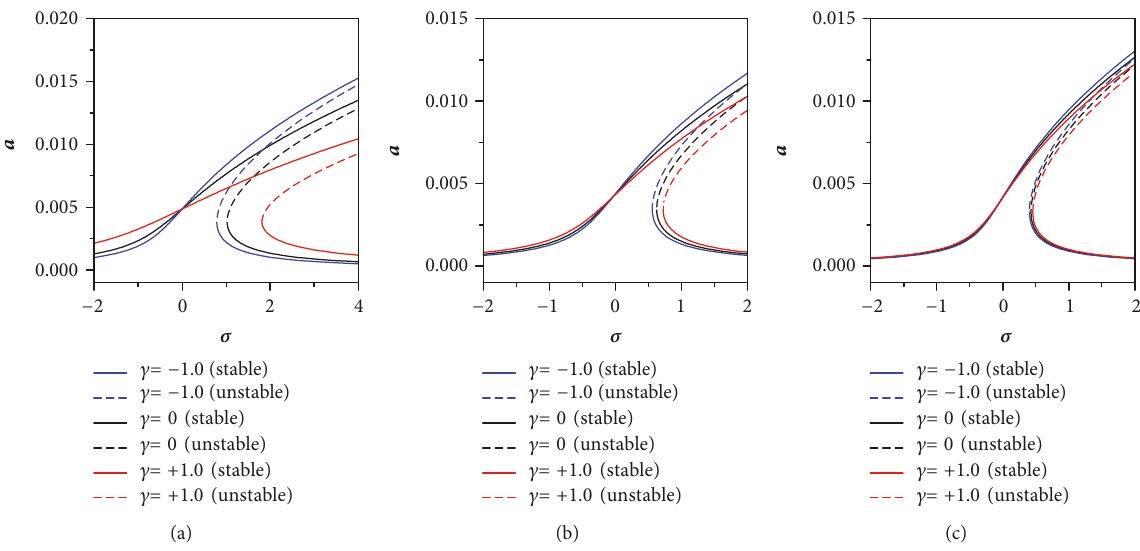
Figure 3: Frequency response curves of primary resonances: (a) hinged-hinged; (b) hinged-fixed; (c) fixed-fixed.